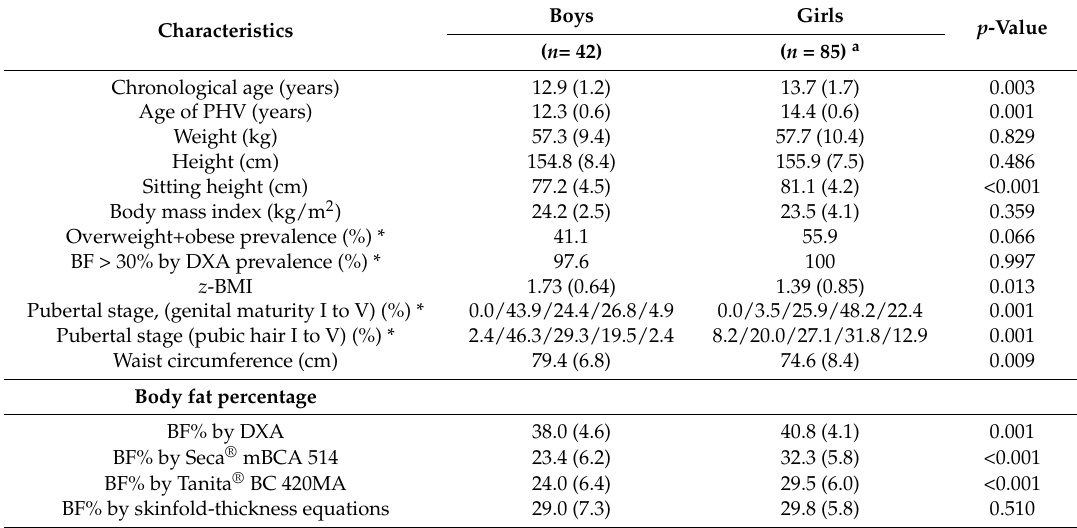
Table 1. Descriptive characteristics of HEPAFIT study participants by